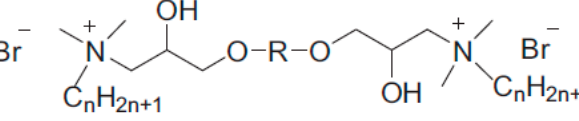
Figure 7. cmc as a function of spacer length from m = 2–12 in ((C ₁₆ Im) ₂ (CH ₂ ) m )Br ₂ series [157].